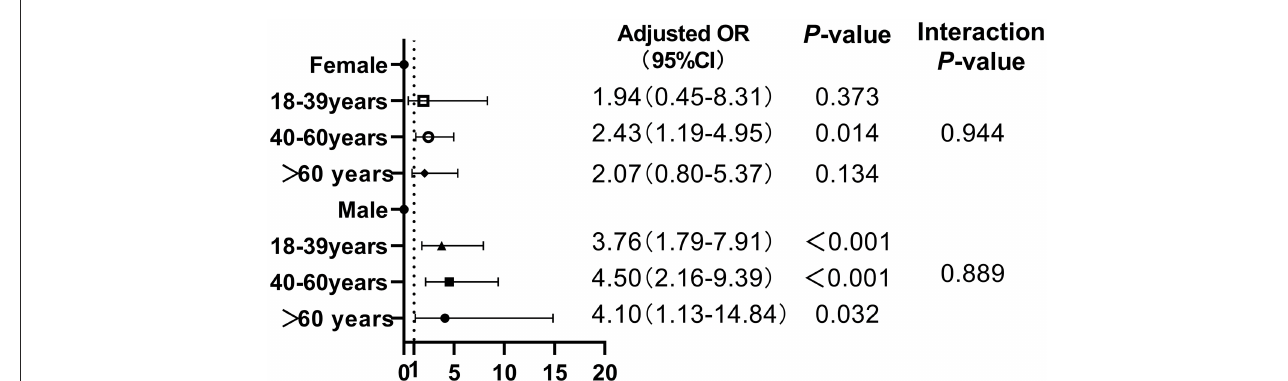
FIGURE3 Association between low muscle mass and NAFLD risk stratified by gender and